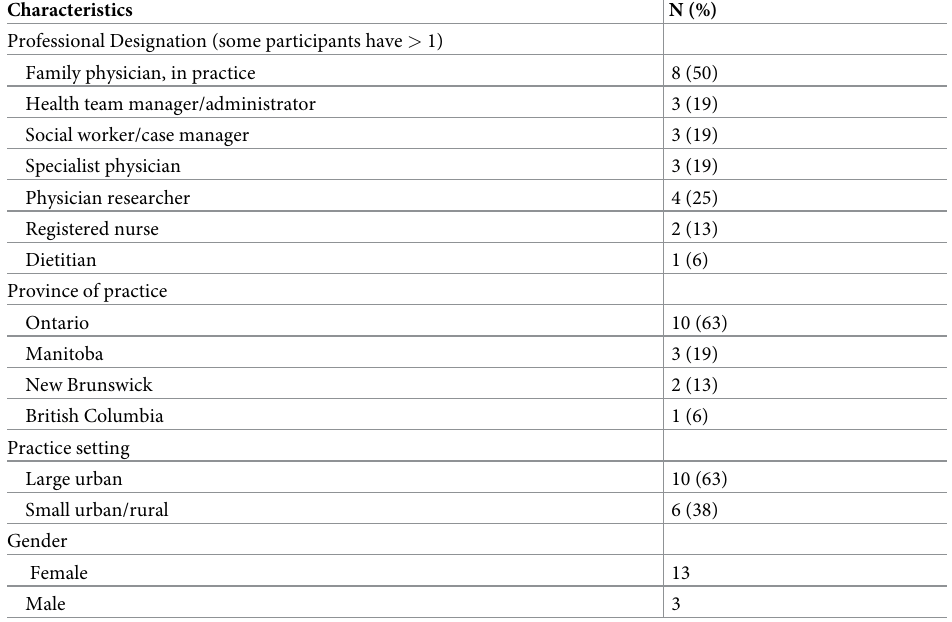
Table 1. Participant